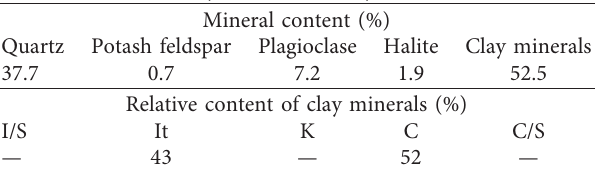
Figure 1: Tunnel construction location and geological profile. (a) Tunnel location. (b) Geological section. (c) Characteristics of surrounding rock. Table 1: X-ray diffraction analysis of